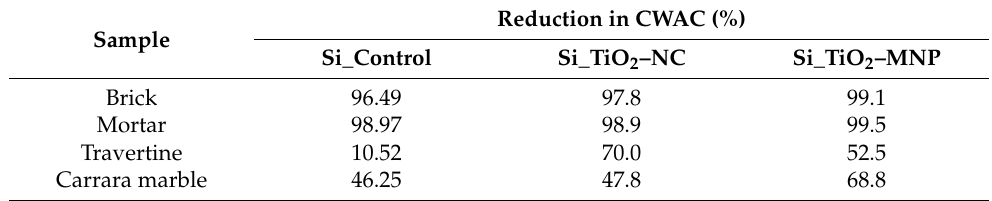
Figure 3. Plot of water absorption by capillarity test as a function of time: ( a ) brick, ( b ) brick (focus 0–35 s 1/2 ), ( c ) mortar, ( d ) mortar (focus 0–35 s 1/2 ), ( e ) travertine and ( f ) Carrara marble. Table 4. Reduction (%) of the capillary water absorption coefficient (CWAC), due to the